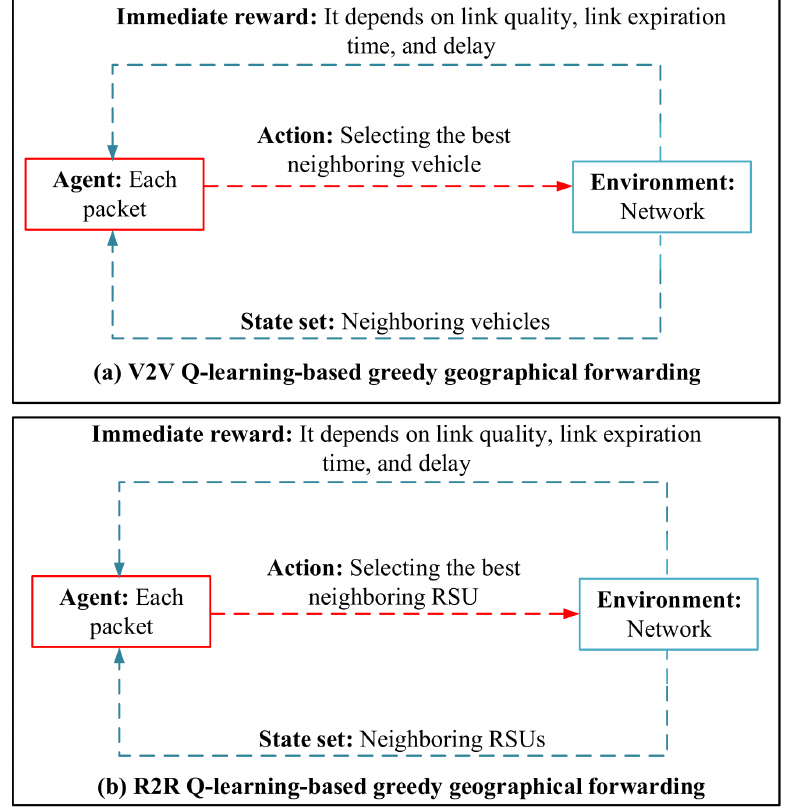
Figure 15. Learning structure in